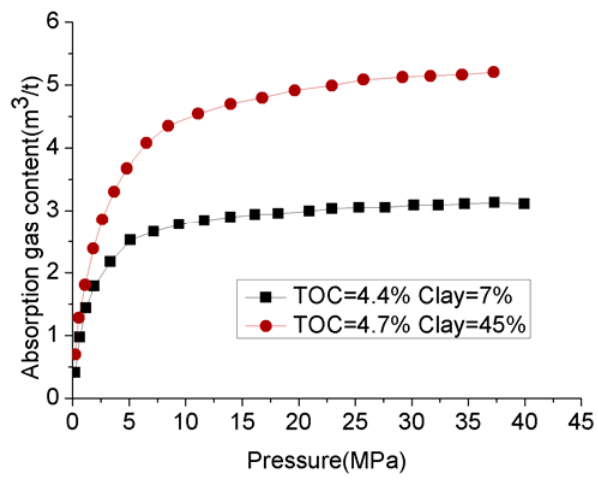
Figure 6 . Relationship between absorption gas content and clay content. Figure 6. Relationship between absorption gas content and clay